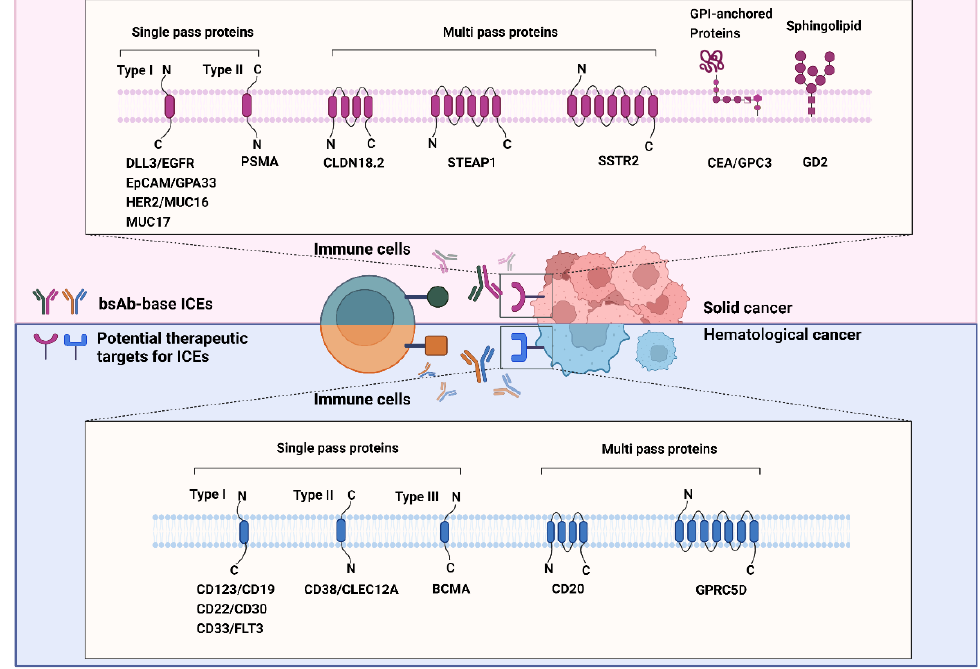
Figure 2. Known and emerging targets for immune-cell engager (ICE) therapy against cancers. The schematic representation shows known and emerging therapeutic targets of bispecific antibody- based ICEs in solid (red background) and hematological (blue background) cancers. All therapeutic targets listed in this figure are grouped on the basis of their relationship with the bilayer and transmembrane topology.